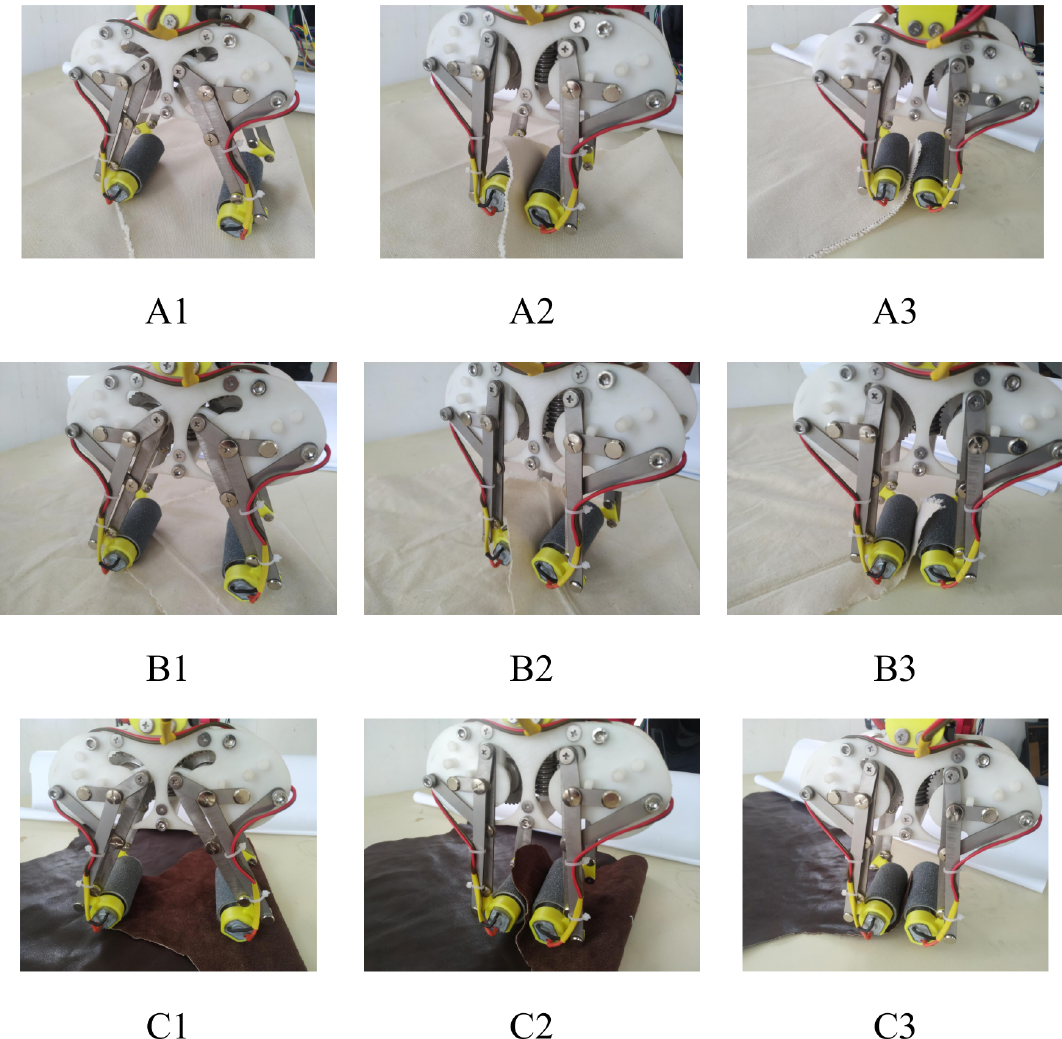
Figure 17. Experiment of fabric corner grabbing and